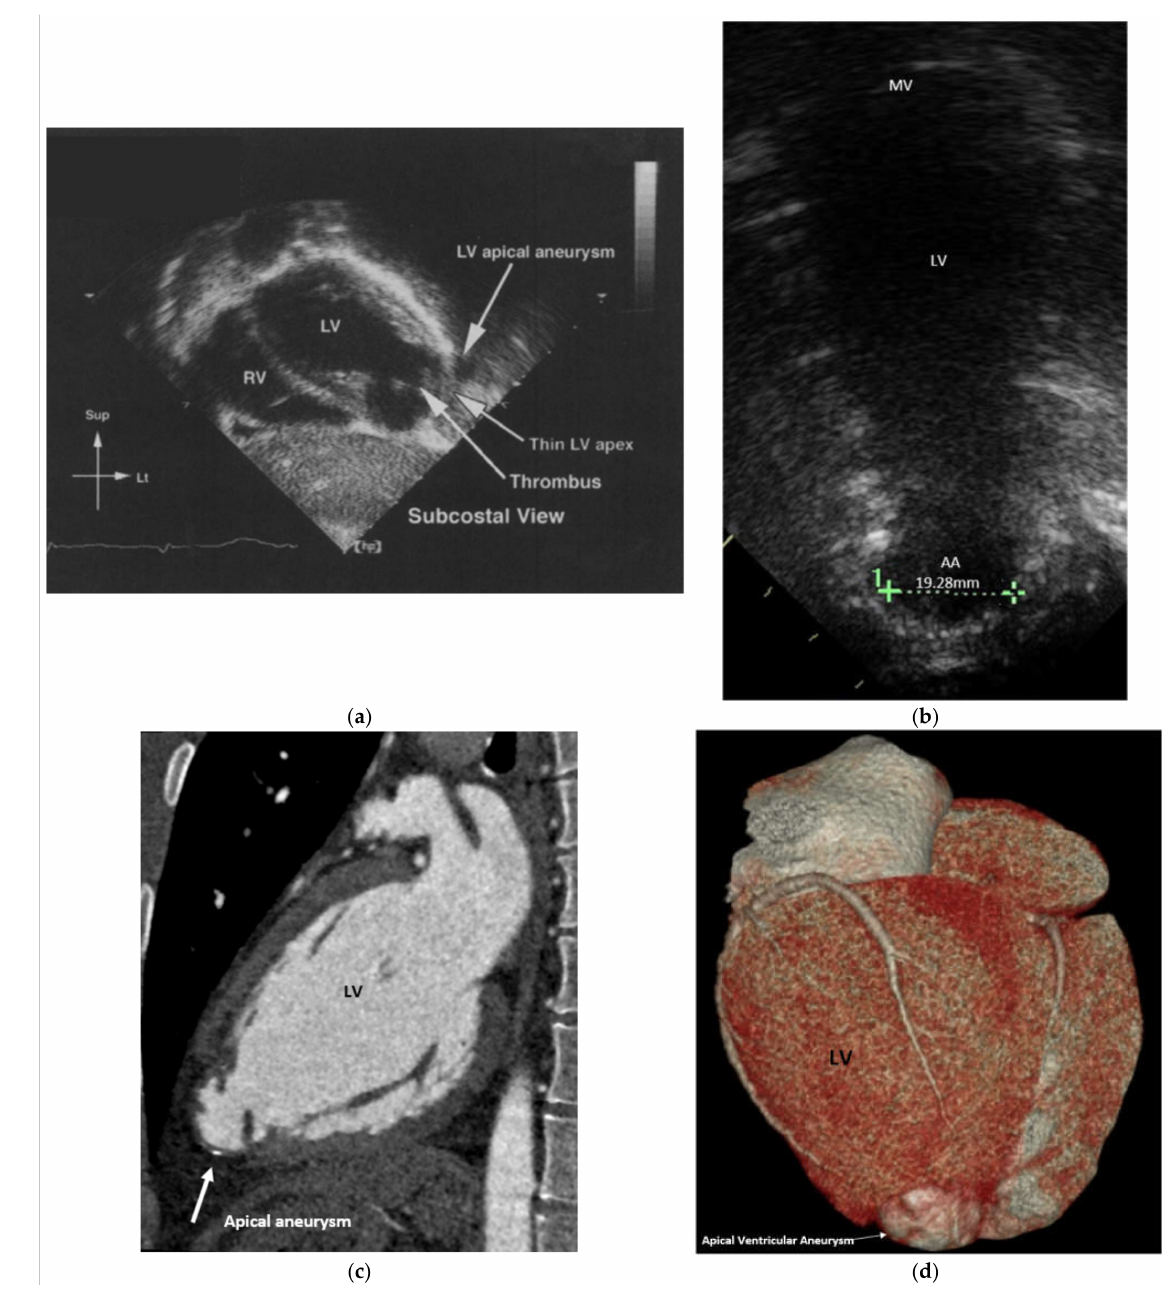
Figure 1. ( a ) Apical aneurysm of the left ventricle. Note the thin wall of the aneurysm and the development of a laminated thrombus. Patient aged 11 months. Reprinted with permission from Cambridge University Press. Licence number 5156740066045 [5]; ( b ) current two-chamber apical view of left ventricle showing the apical aneurysm; ( c ) recent CT image of the left ventricle showing the apical aneurysm; ( d ) reconstituted CT image of the posterior aspect of the left ventricle showing the pale ischaemic apical aneurysm. Sup = superior, Lt = left, LV = left ventricle, RV = right ventricle, MV = mitral valve, AA = apical